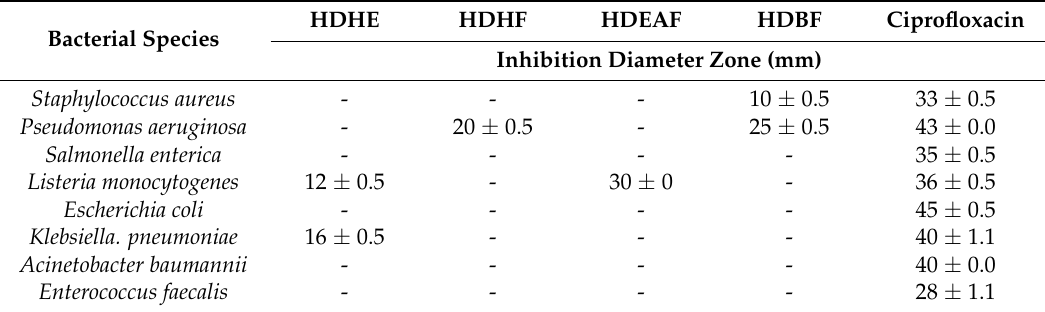
Table 1. Antimicrobial activity of hydroalcoholic extract from leaves of Himatanthus drasticus and its fractions.